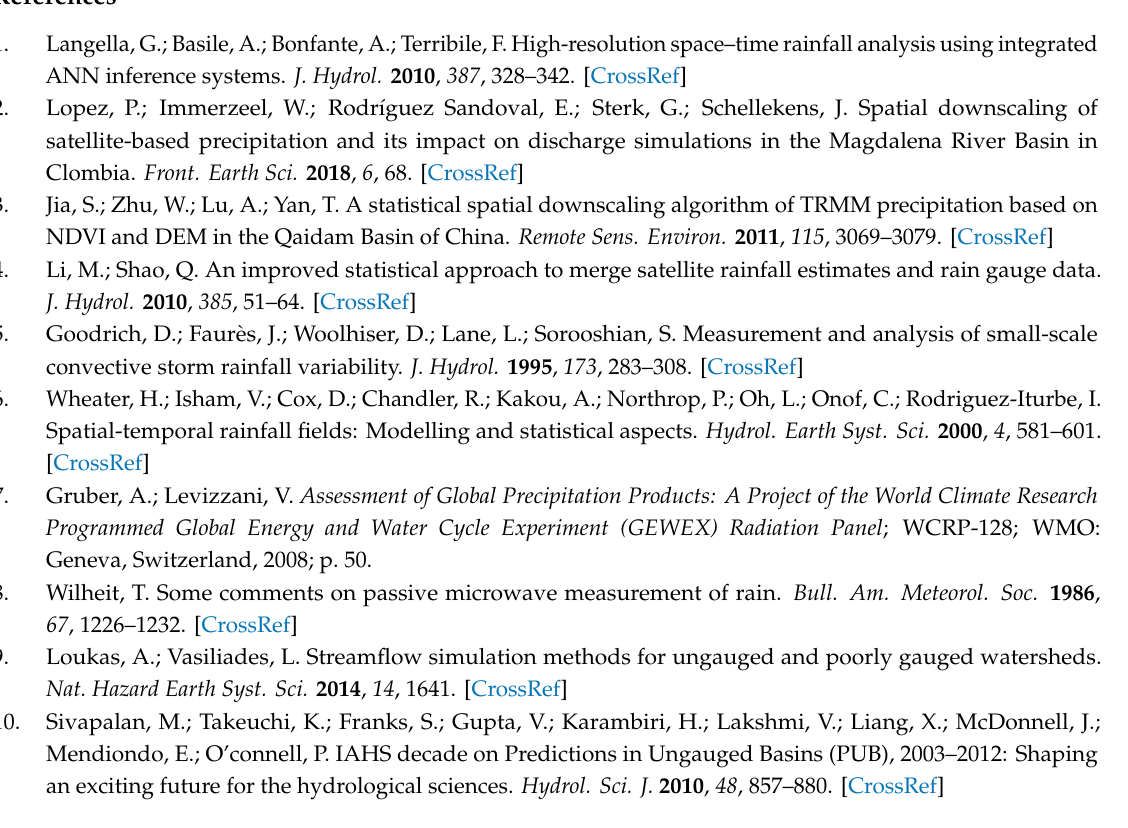
Figure S1: Grids conversion into points located at the center of each pixel (a) 0.25 ◦ resolution, (b) 0.50 ◦ resolution, (c) 0.75 ◦ resolution, (d) 1.0 ◦ resolution, (e) 1.25 ◦ resolution, (f) 1.50 ◦ resolution, respectively; Figure S2: Execution of EDBF algorithm for estimating the weighted precipitation at di ff erent scaled resolutions; Figure S3: Per meter elevation received precipitation at 0.25 ◦ , 0.50 ◦ , 0.75 ◦ , 1.0 ◦ , 1.25 ◦ and 1.50 ◦ resolution for (a) the average monthly, (b) the average annual (2001–2015), (c) the average winter, (d) the average spring, (e) the average summer, (f) the average autumn, (g) the dry-year (2001), (h) the wet-year (2004) precipitation, respectively; Figure S4: Per degree longitude received precipitation at 0.25 ◦ , 0.50 ◦ , 0.75 ◦ , 1.0 ◦ , 1.25 ◦ and 1.50 ◦ resolution for (a) the average monthly, (b) the average annual (2001–2015), (c) the average winter, (d) the average spring, (e) the average summer, (f) the average autumn, (g) the dry-year (2001), (h) the wet-year (2004) precipitation, respectively; Figure S5: Per degree latitude received precipitation at 0.25 ◦ , 0.50 ◦ , 0.75 ◦ , 1.0 ◦ , 1.25 ◦ and 1.50 ◦ resolution for (a) the average monthly, (b) the average annual (2001–2015), (c) the average winter, (d) the average spring, (e) the average summer, (f) the average autumn, (g) the dry-year (2001), (h) the wet-year (2004) precipitation, respectively; Figure S6: Generation of the high-resolution weightged residuals (g)(h)(i) at 0.05 ◦ from the low-resolution weighted residuals (d–f) at 0.75 ◦ for, (a) the dry yar (2001), (b) the wet year (2005), and (c) the average annual (2001–2015) precipitatation at 0.75 ◦ resolution, respectively. Table S1: Data Summary for the calculation of Chi-square test value; Table S2: Comparison between the weighted precipitation and the multitemporal precipitation variables at di ff erent resolution